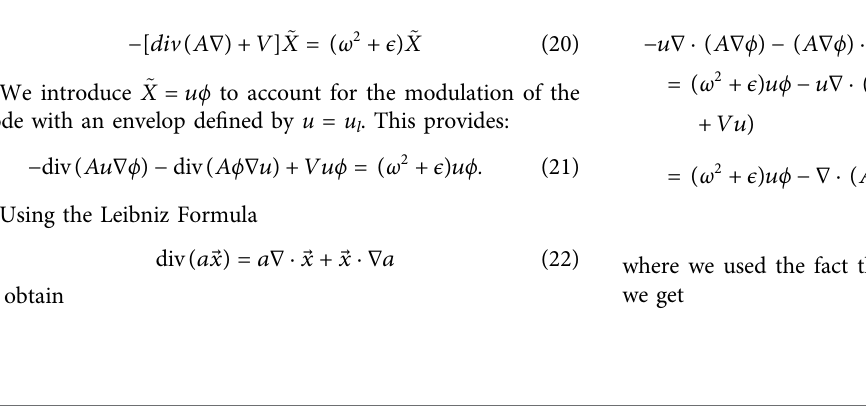
Frontiers in Molecular Biosciences |